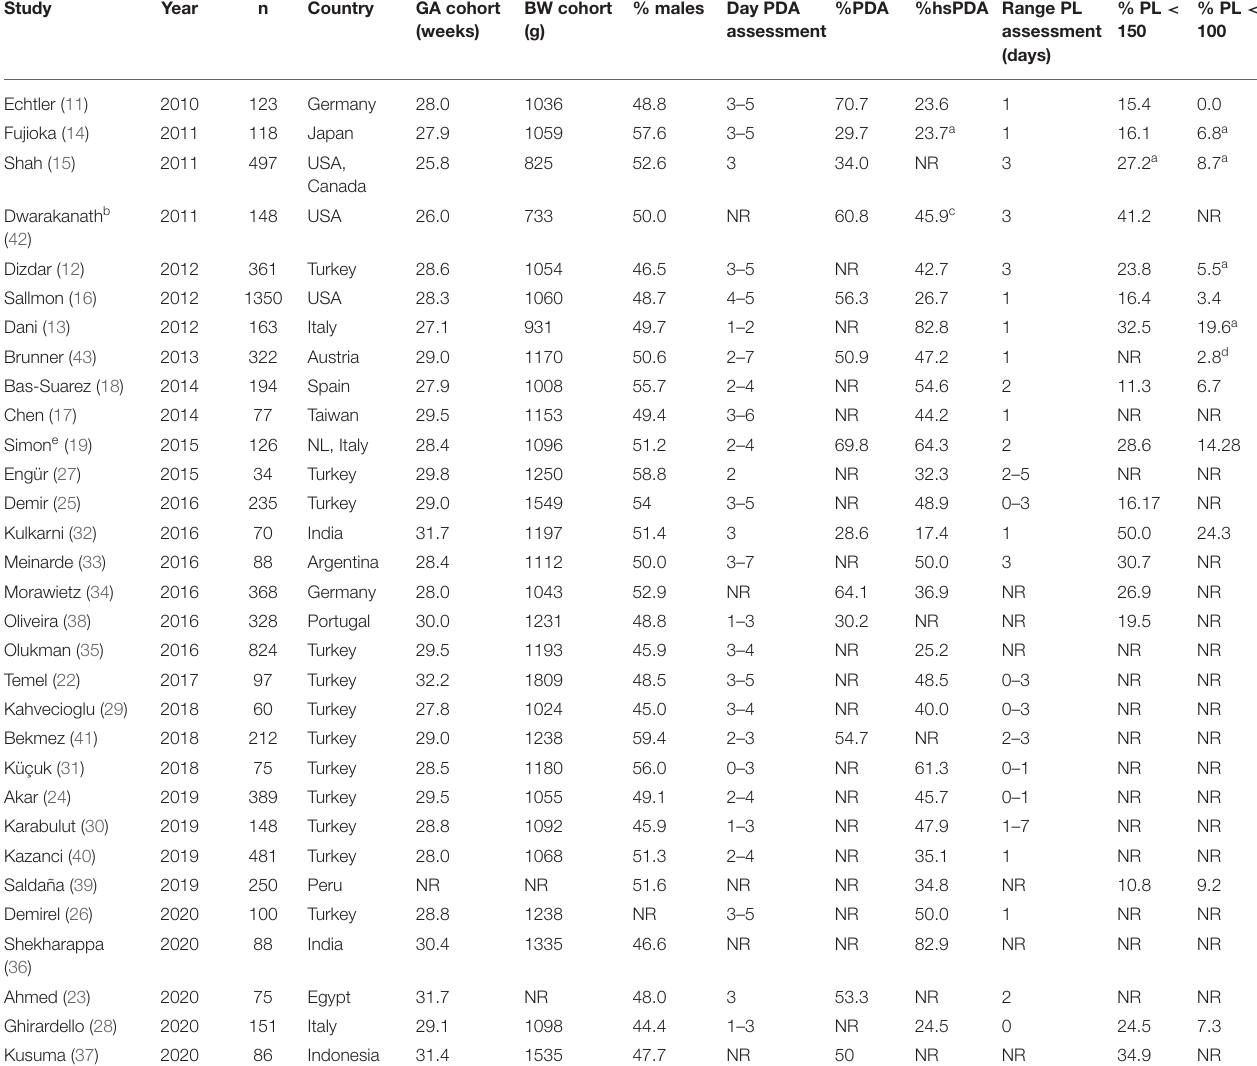
TABLE 1 | Characteristics of the studies included in the meta-analysis.